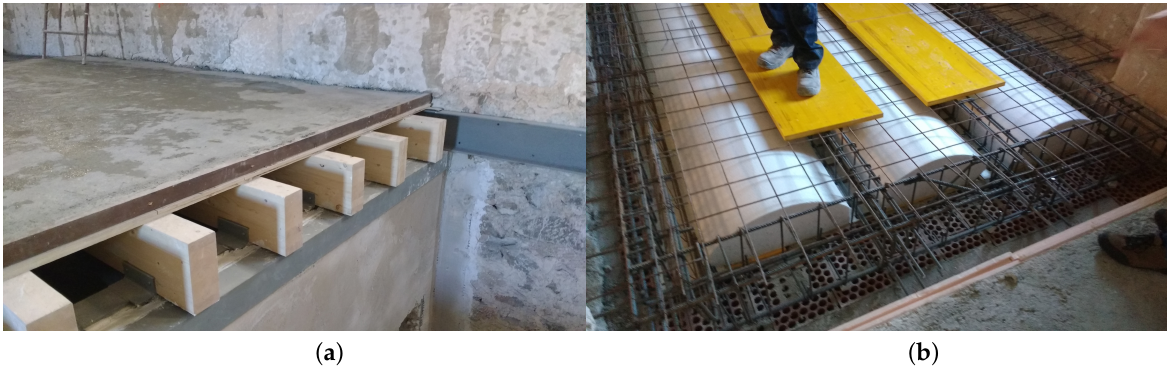
Figure 4. ( a ): Slabs using laminated wood beams. ( b ): Joists-beam concrete slab built in